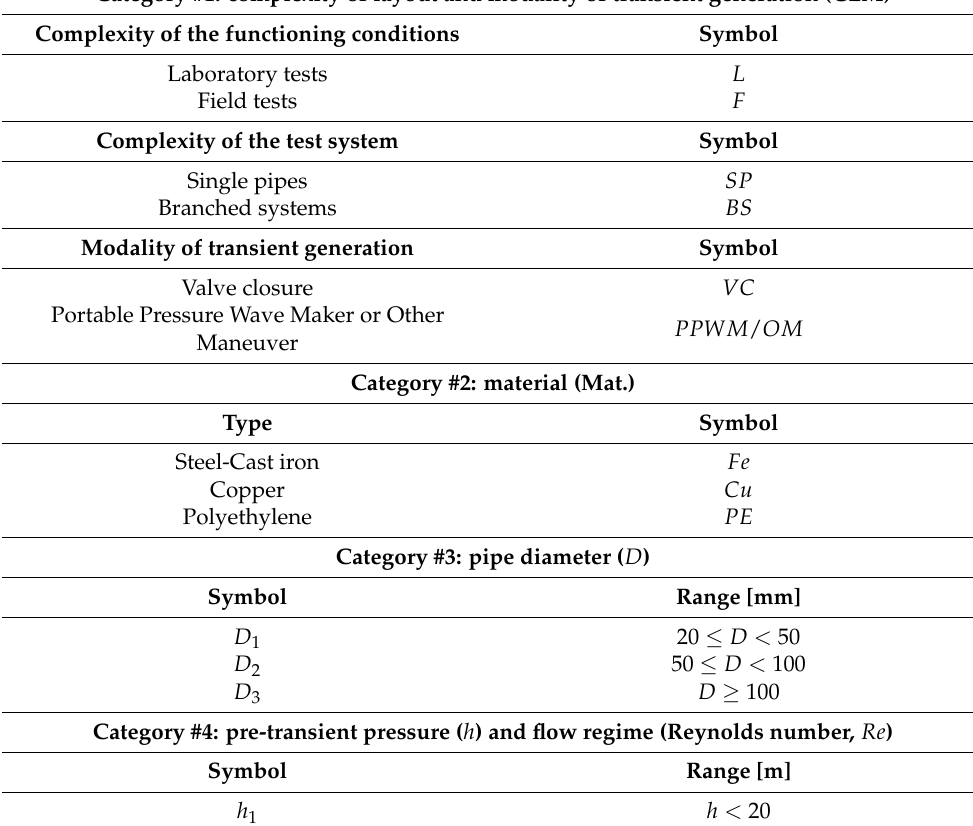
Table 3. Meanings of the abbreviations used in Table 2. Category #1: complexity of layout and modality of transient generation